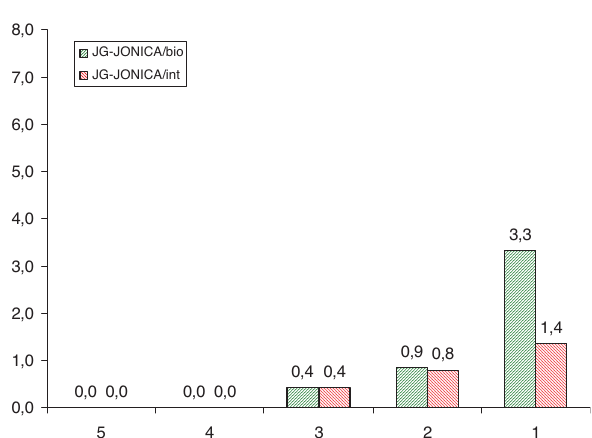
Figure5. Number of inflorescences on the fruiting structures of different age on the variety JONICA depending also on the growing